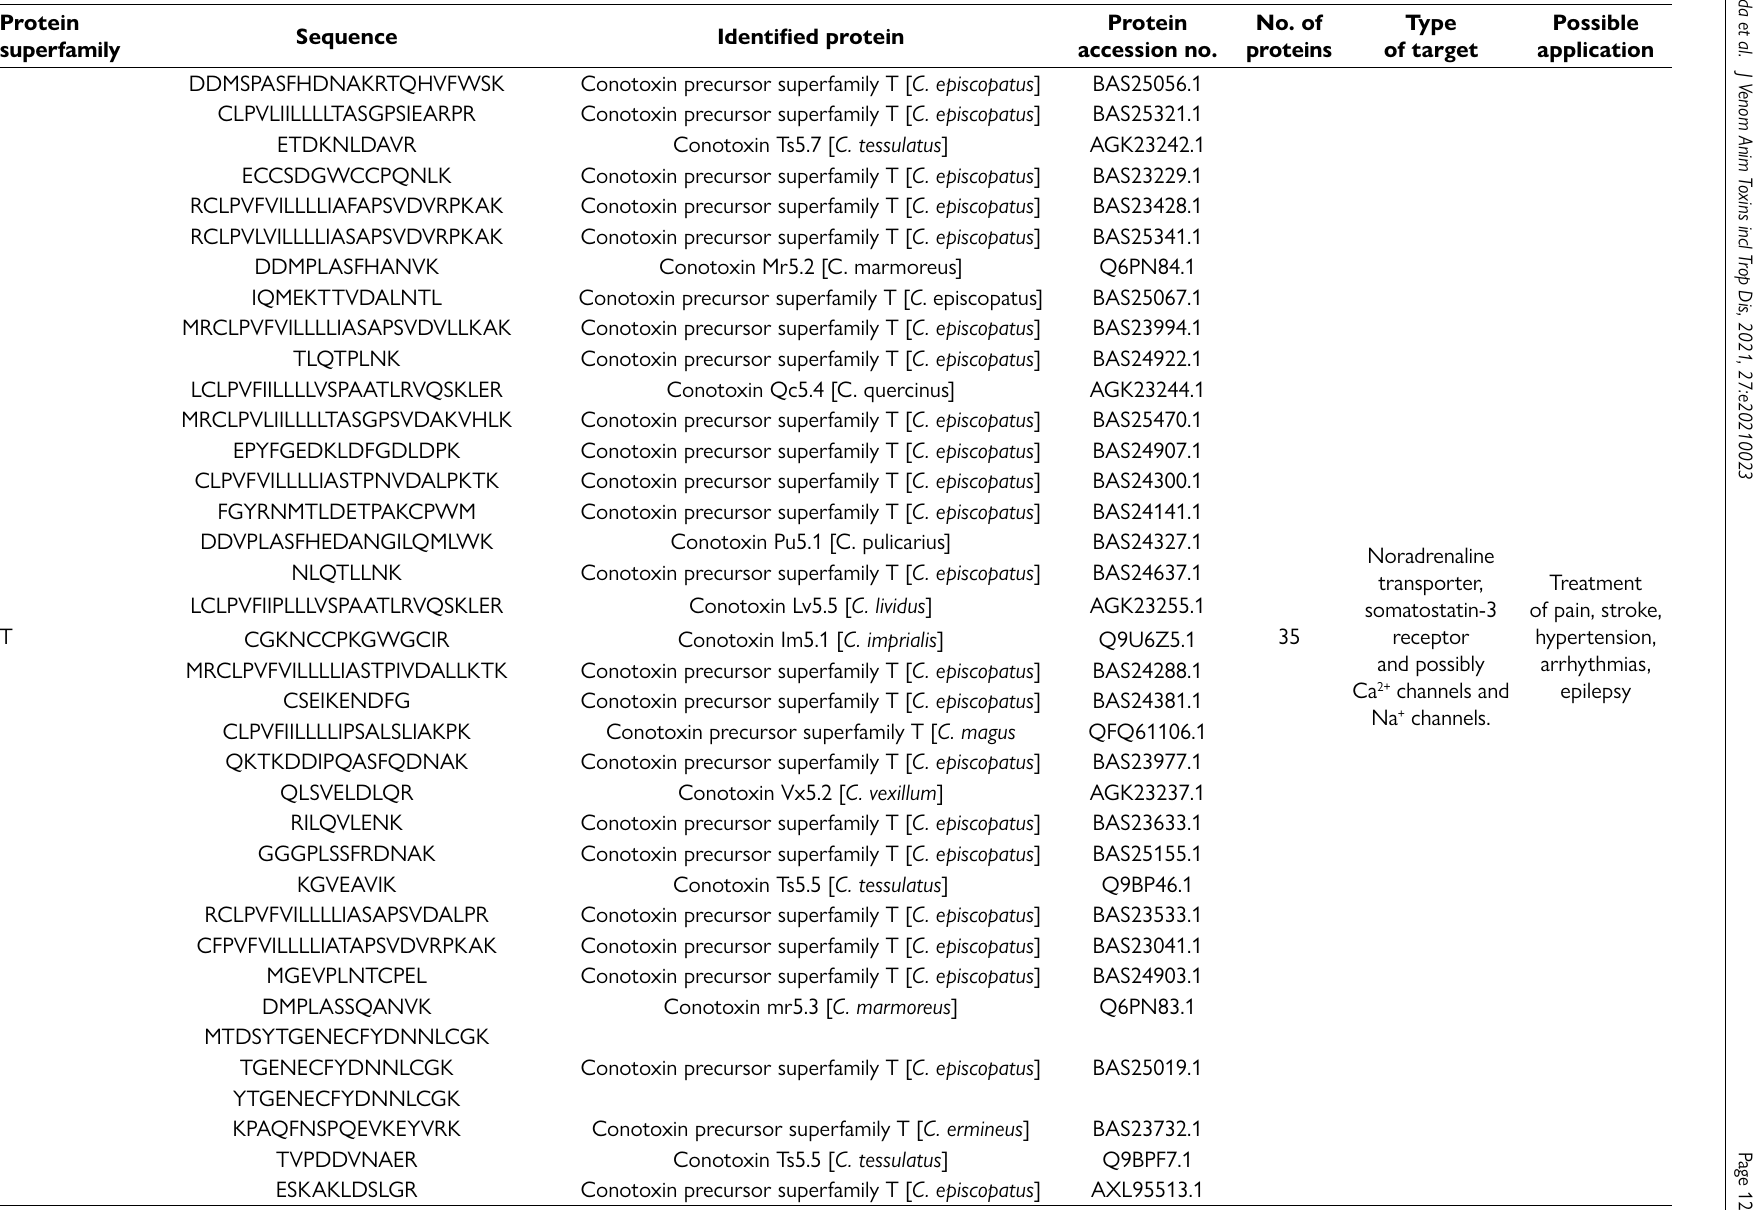
Table 1. Protein